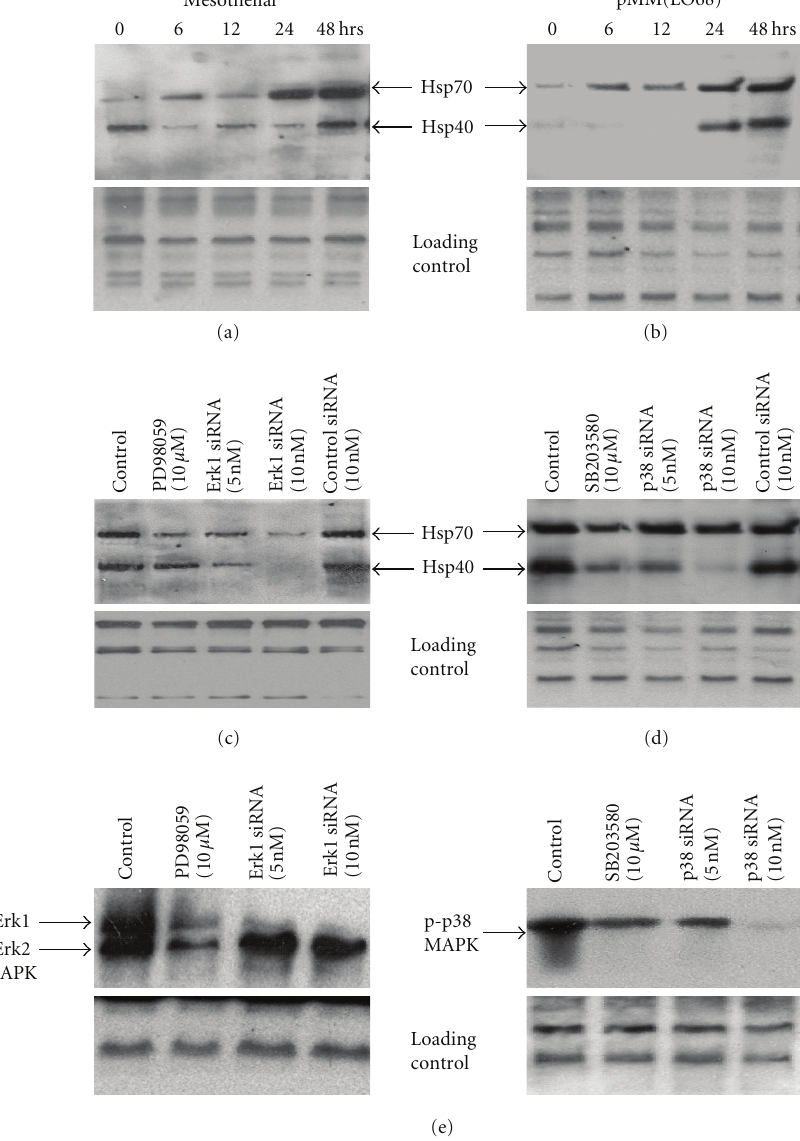
Figure 3: Heat stress induces Hsp expression. Representative immunoblots of of Hsp70 and Hsp40 expression after heat stress (40 ◦ C, 20 minutes) by (a) mesothelial cells and (b) PDMM cells (LO68). (c) Erk1/2 MAPK mediated the heat stress-induced (40 ◦ C, 20 minutes) expression of Hsp70 and Hsp40 by PDMM cells (LO68). (d) p38 MAPK mediated heat stress-induced (40 ◦ C, 20 minutes) expression of Hsp40 and Hsp70 expressions in PDMM cells (LO68). Similar results were obtained in the two other PDMM cell lines and in mesothelial cells. (e) Specific protein suppression by siRNAs for Erk1 or p38 MAPK in PDMM cells (LO68). Coomasie blue was used to control equal protein loading (loading